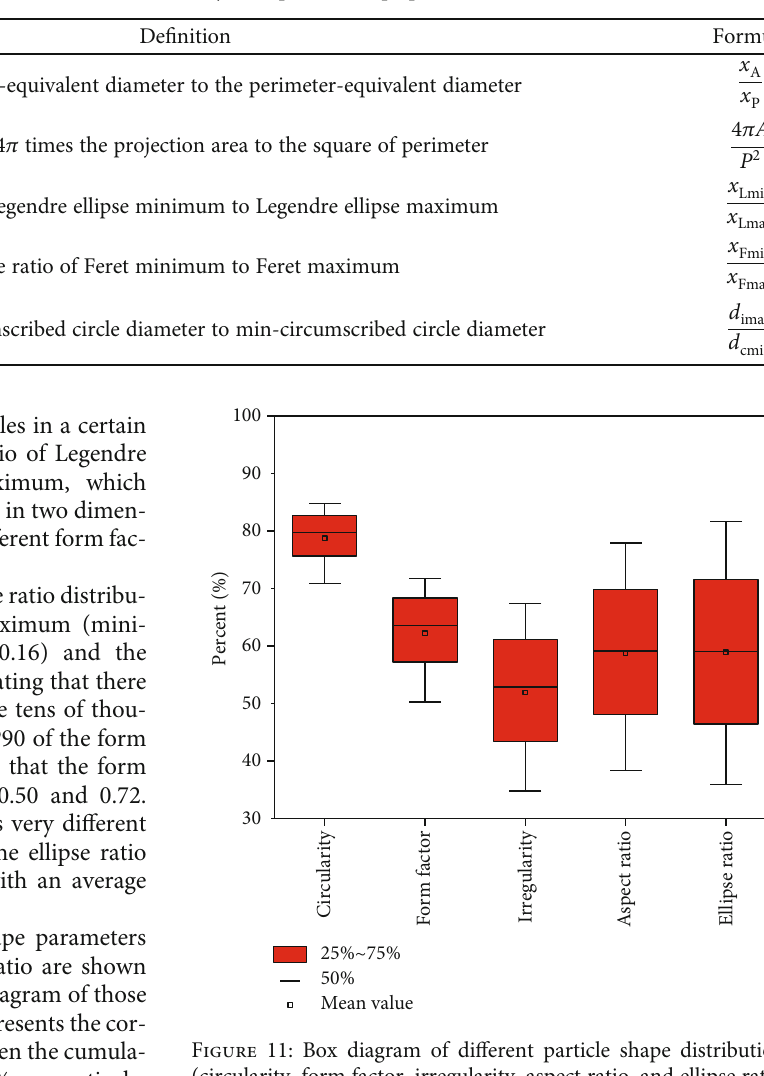
Table 3: The de fi nitions of some commonly used particle shape parameters.